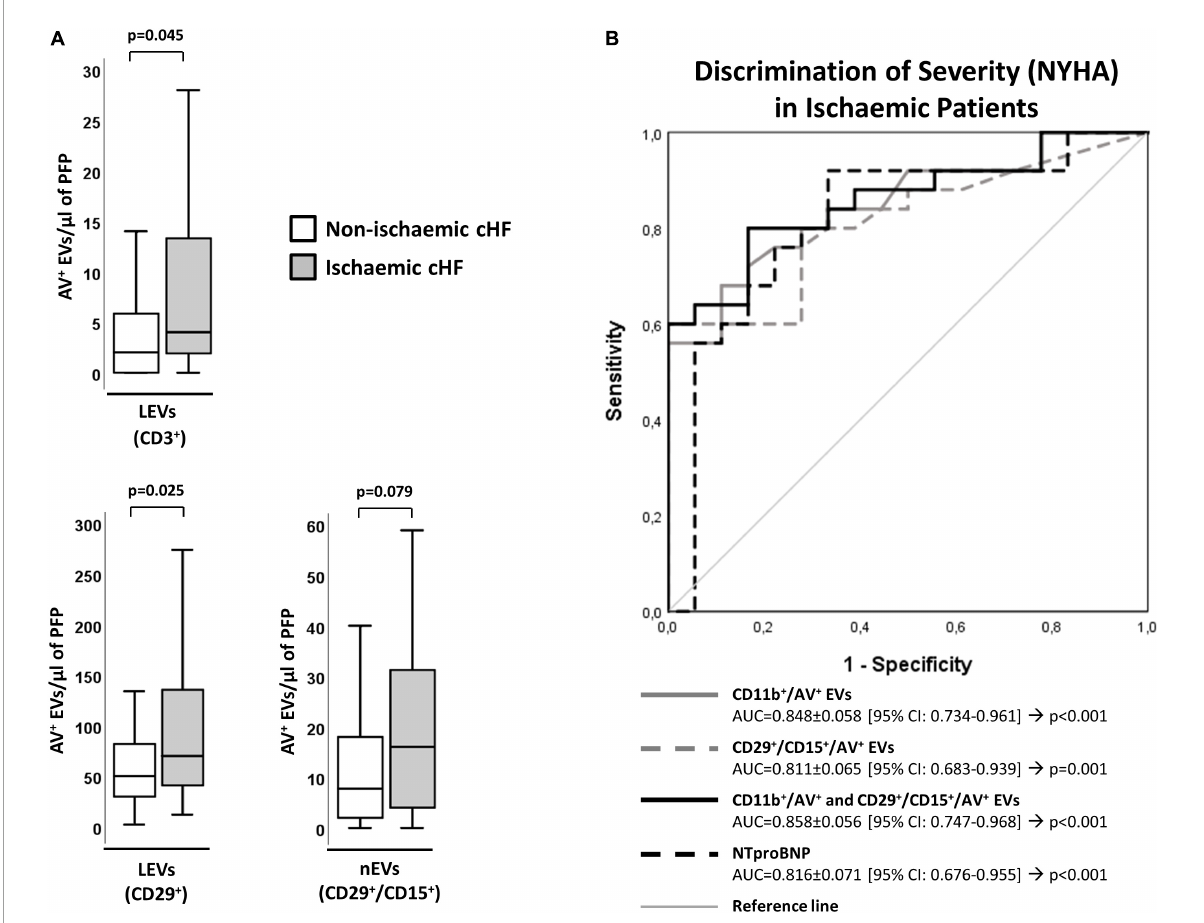
FIGURE3 Distribution of AV + -EVs from immune-cell origin considering disease etiology. (A) Distribution of EVs from T-lymphocytes (CD3 + ), activated leukocytes (CD29 + ) and from activated neutrophils (CD29 + /CD15 + ). A p < 0.05 was considered significant (U Mann–Whitney test). (B) ROC curve analyses were used to evaluate the impact of EVs and combinations of EVs with NT-proBNP on HF severity (NYHA) in ischemic patients (AUC indicated along its 95% CI). A p < 0.05 was considered significant. AUC, area under the curve; AV + , annexin V + ; cHF, chronic heart failure; CI, confidence interval; EVs, extracellular microvesicles; LEVs, leukocyte-derived EVs; lEVs, lymphocyte-derived EVs; nEVs, neutrophil-derived EVs; NYHA, New York Heart Association; PFP, platelet-free plasma; ROC, receiver operating characteristic